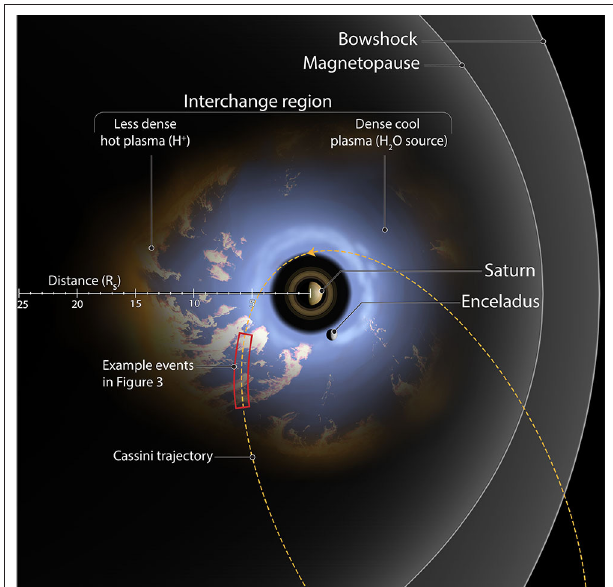
FIGURE 2 | Diagram of interchange injection in the Saturn system. The illustrated orbit is an equatorial Cassini orbit from 2005. Injections are denoted by the pale orange material interspersed with the water sourced plasma from Enceladus. Along the example orbit the red box denotes a hypothetical segment of Cassini data discussed in Figure 3 . The purpose of developing an automated event detection is to identify the pale orange material traveling toward the planet. This figure is produced in consultation with, and copyright permissions from Falconieri